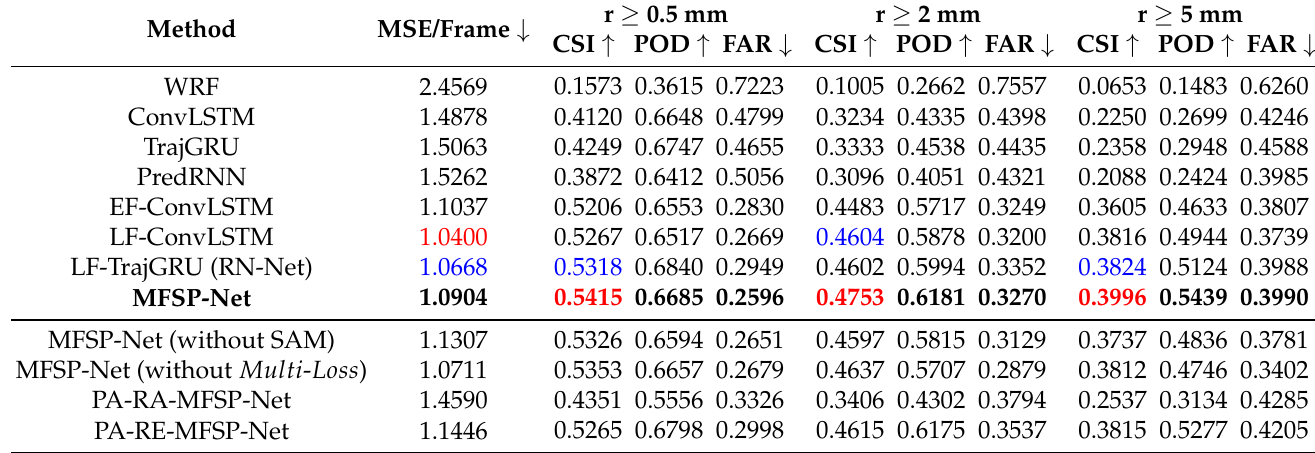
Table 4. Average evaluation results of one frame of precipitation amount nowcasting in the first hour. For MSE and CSI, the best performance is reported using red, and the second best is reported using blue. ” ↑ ” means that the higher the score, the better, while “ ↓ ” means that the lower the score, the better. “ r ≥ γ ” means the skill score at the γ mm precipitation amount threshold in 1 h.